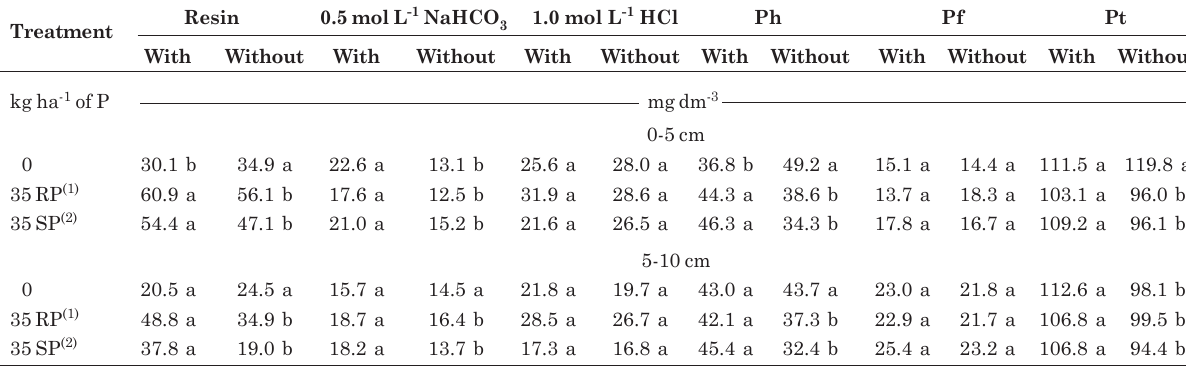
Table 3. Mean values of available P (P-resin), labile organic P (0.5 mol L -1 NaHCO 3 ), moderately labile organic P (1.0 mol L -1 HCl), humic substance bound organic P (Ph), fulvic substance bound organic P